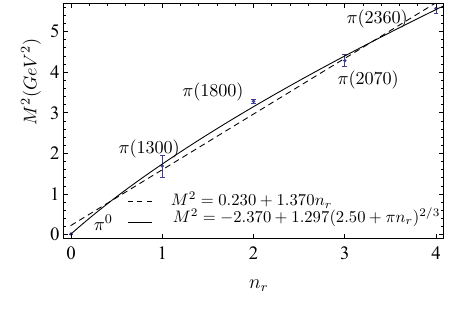
Fig. 8 The radial Regge trajectories for π [25] Table 7 β n of the radial Regge trajectories. β n r the up quark or down quark